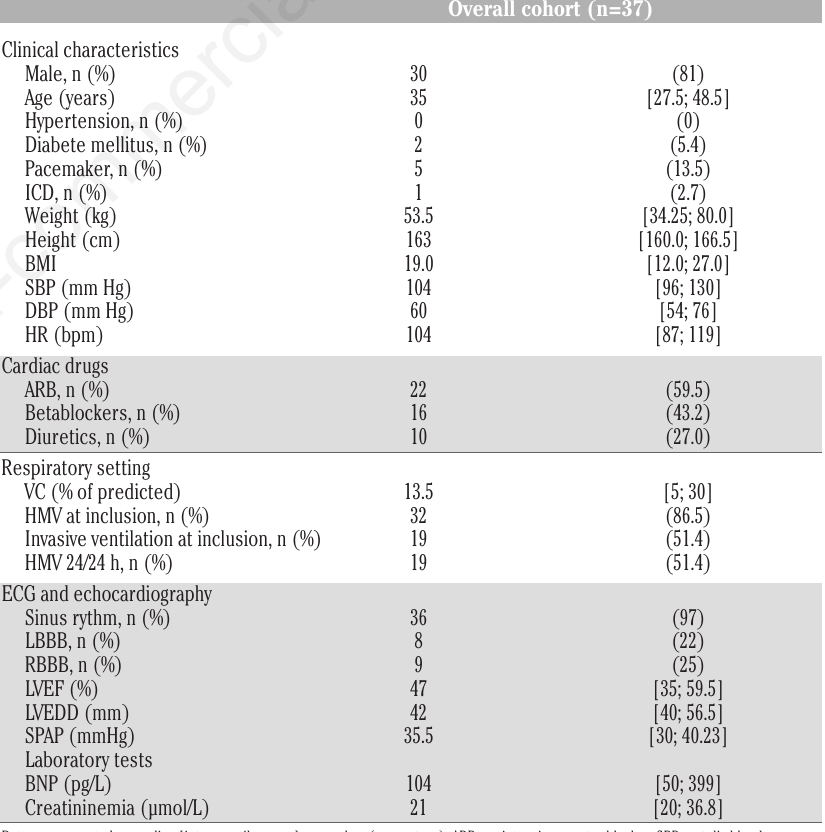
Table 1. Clinical, biological and echocardiographic findings of patients at